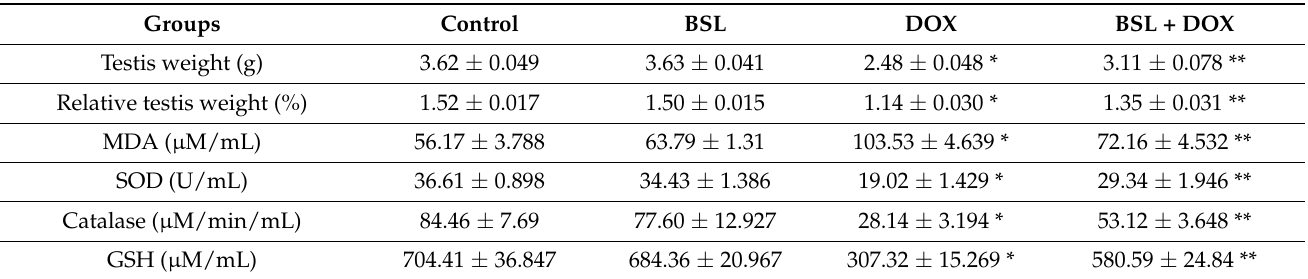
Table 1. Effect of α -bisabolol on testicular weight, relative testicular weight ratio, and oxidative stress markers in DOX-injected